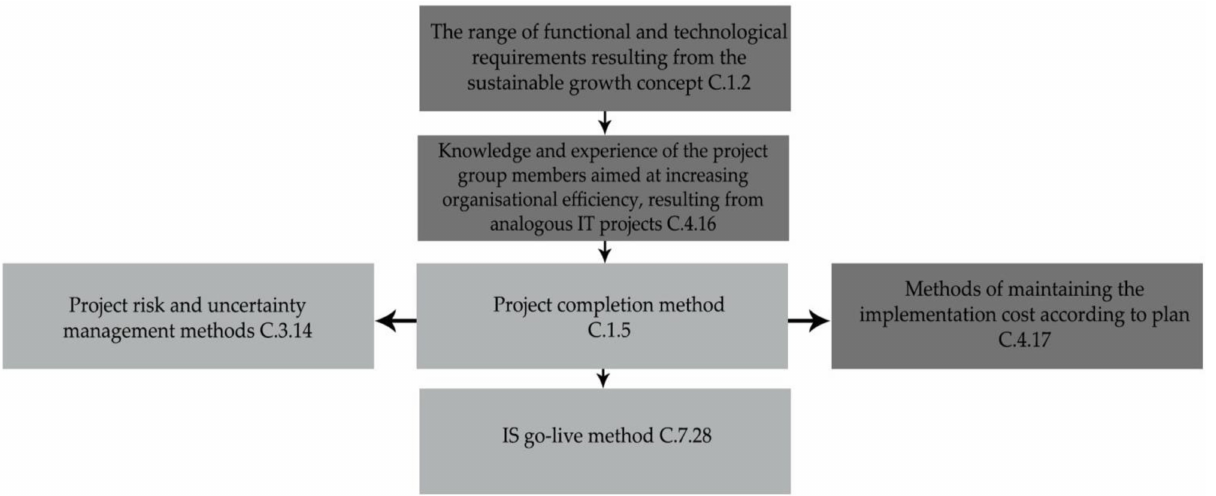
Figure 2. Inheritance of information gaps for the significant components in Stage 2. Source: Own